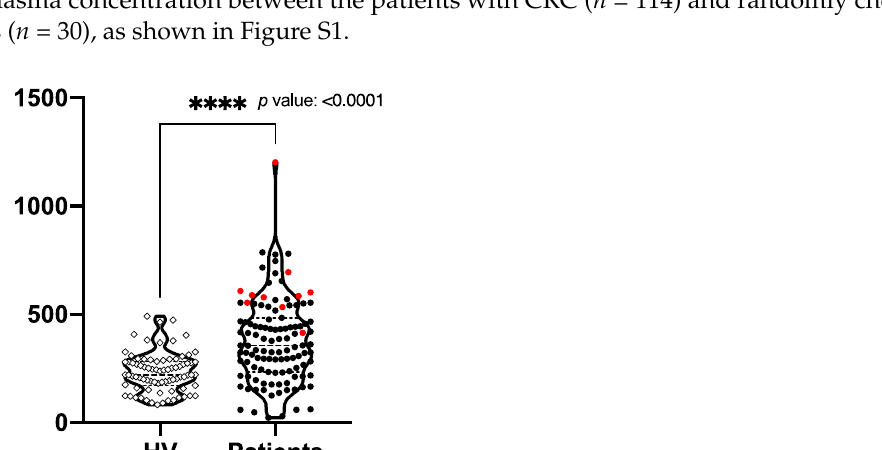
plasma concentration between the patients with CRC ( n = 114) and randomly chosen HVs ( n = 30), as shown in Figure S1.